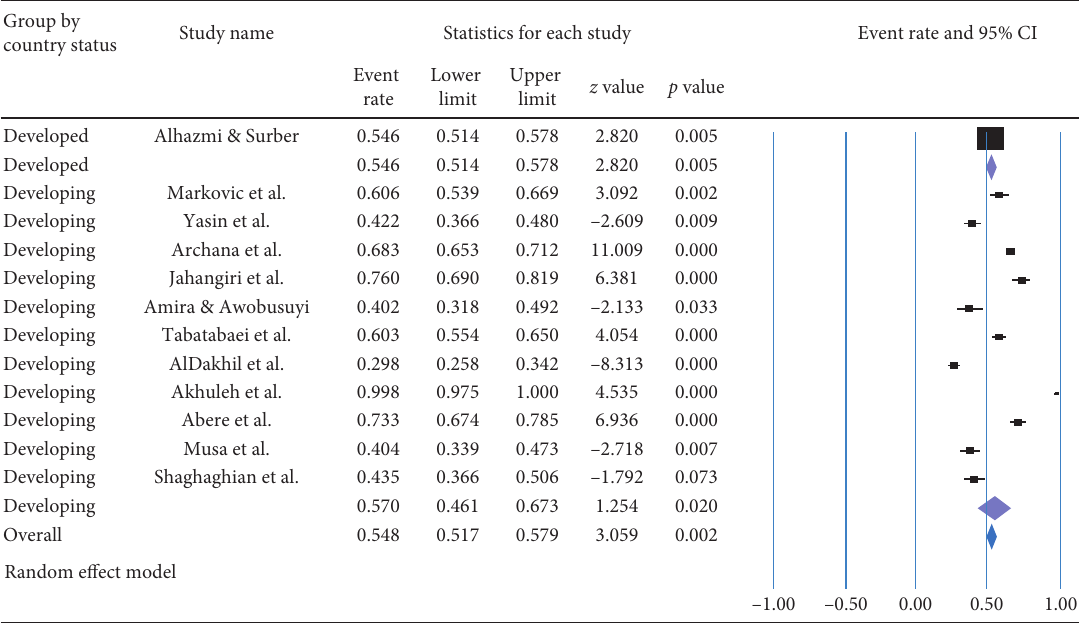
Figure 4: Forest plot shows the subgroup analysis of pooled prevalence of career time occupational exposure to needle stick injury based on socioeconomic development.